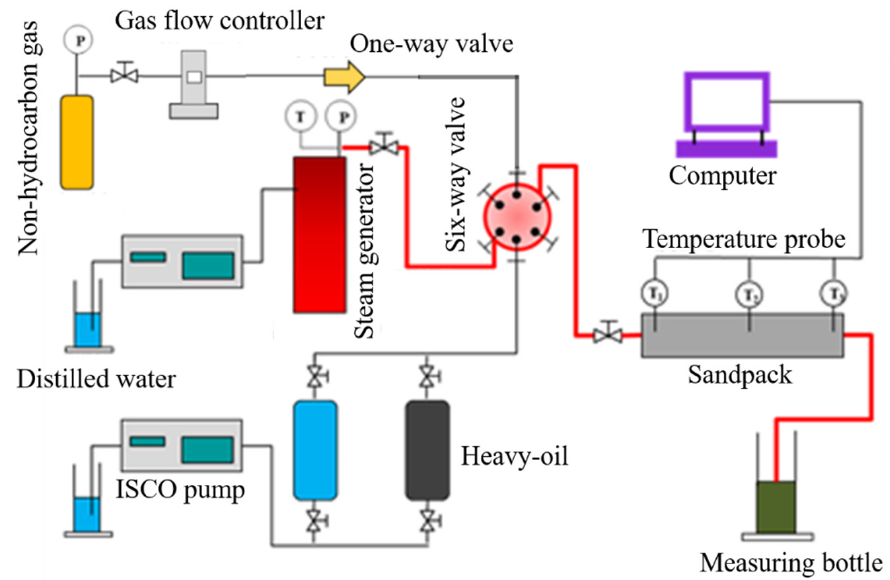
Table 2. Relevant parameters of experimental equipment.